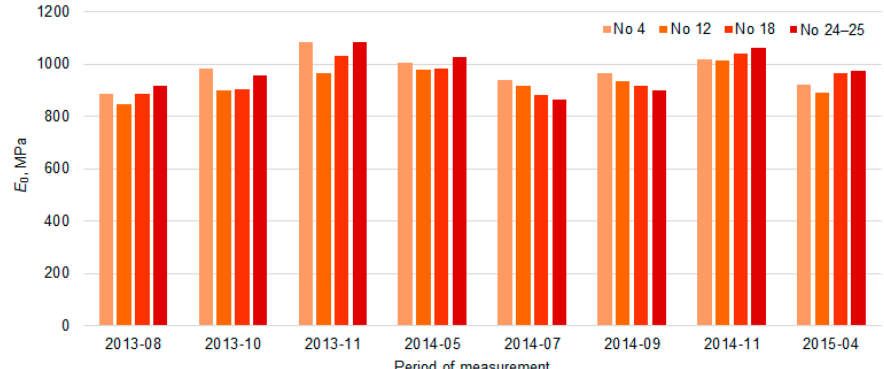
Figure 20. The average values of bearing capacity in different periods of the loaded lane of PS No 4, No 12, No 18 and No 24–25.